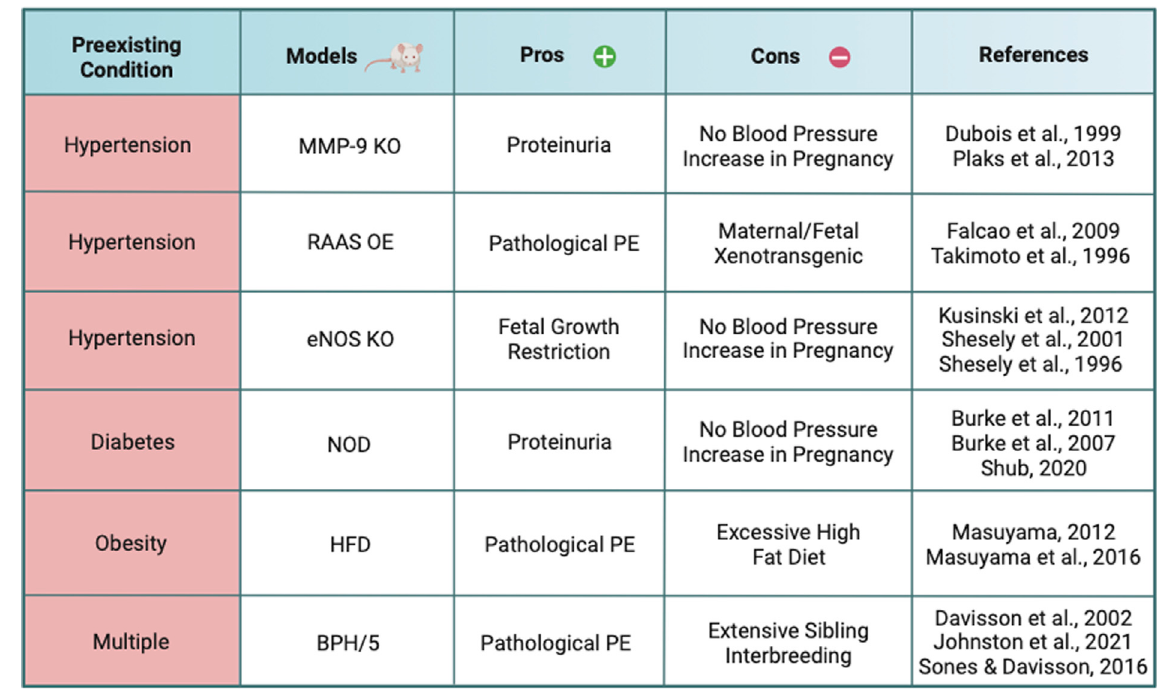
TABLE 1 Current mouse models with preexisting conditions that develop